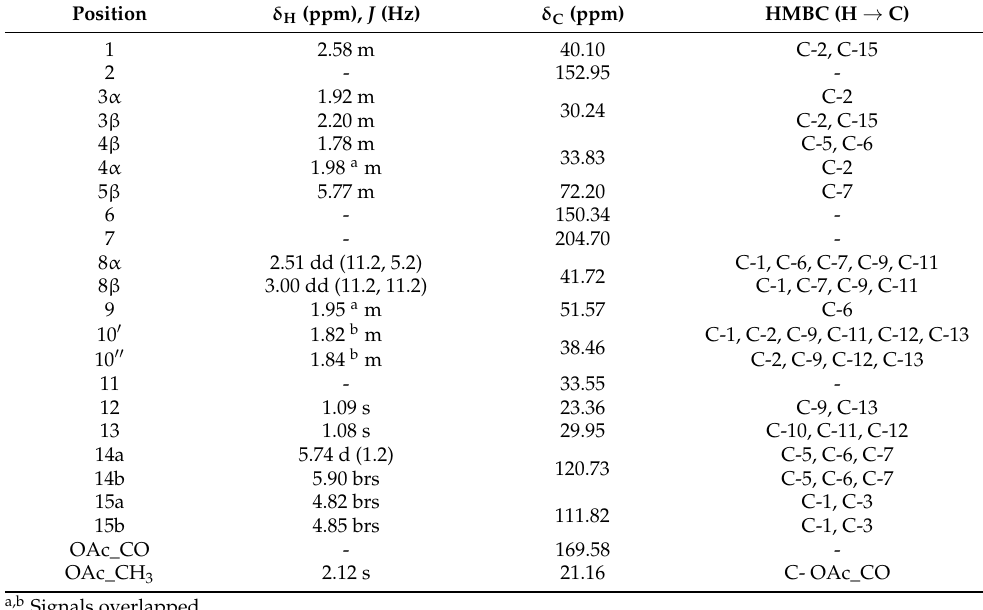
Table 2. 1 H NMR (400.17 MHz) and 13 C NMR (100.63 MHz) data of compound 2 in CDCl 3 .